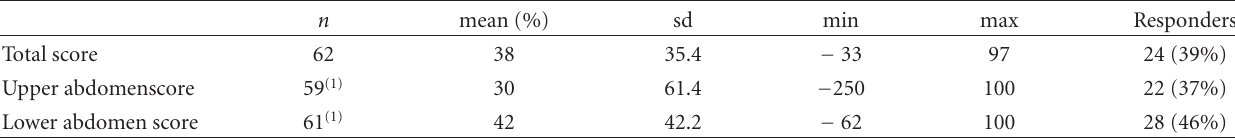
Table 2: Relative changes between V0 and V3 (mean, standard deviation, minimum, maximum, responder frequency). n mean (%) sd